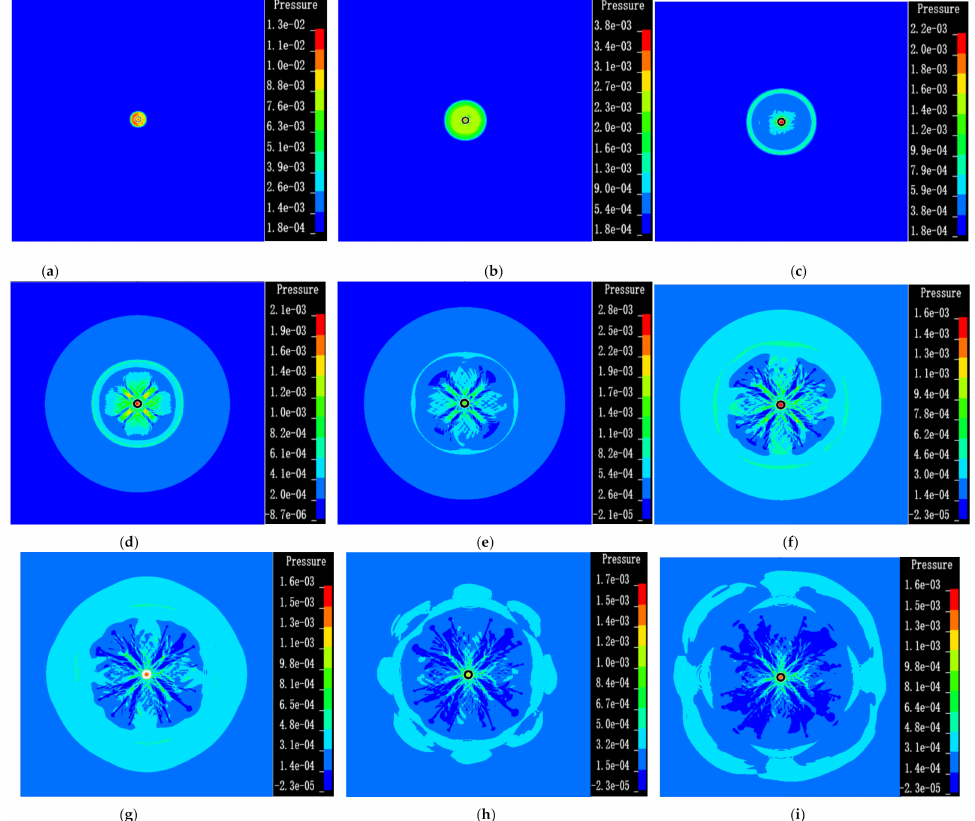
Figure 5. Dynamic load propagation process of single-hole blasting. ( a ). Explosion time 29.79 µ s ( b ). Explosion time 89.77 µ s. ( c ) Explosion time 159.93 µ s. ( d ) Explosion time 219.88 µ s. ( e ) Explosion time 269.84 µ s. ( f ) Explosion time 359.93 µ s. ( g ) Explosion time 399.81 µ s. ( h ) Explosion time 449.95 µ s. ( i ) Explosion time 500.07 µ s.